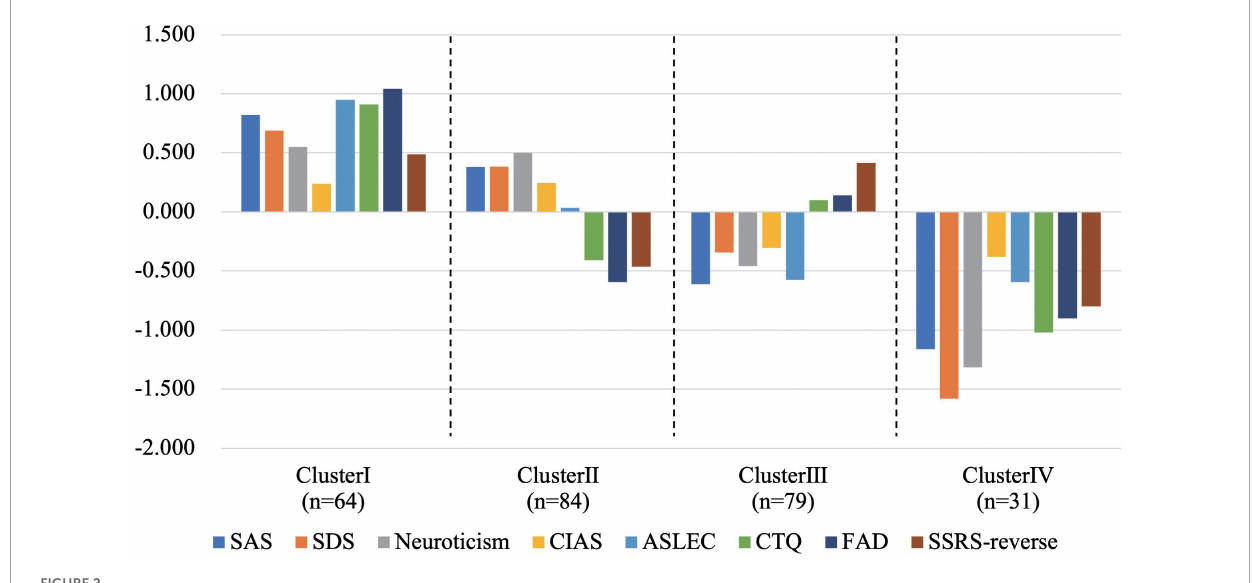
FIGURE2 The four cluster centers of risk factors. Cluster I-Unfavorable Internal personal characteristics and Unfavorable External environmental characteristics (UIUE); Cluster II-Unfavorable Internal personal characteristics and Favorable External environmental characteristics (UIFE); Cluster III-Favorable Internal personal characteristics and Unfavorable External environmental characteristics (FIUE); Cluster IV- Favorable Internal personal characteristics and Favorable External environmental characteristics (FIFE).